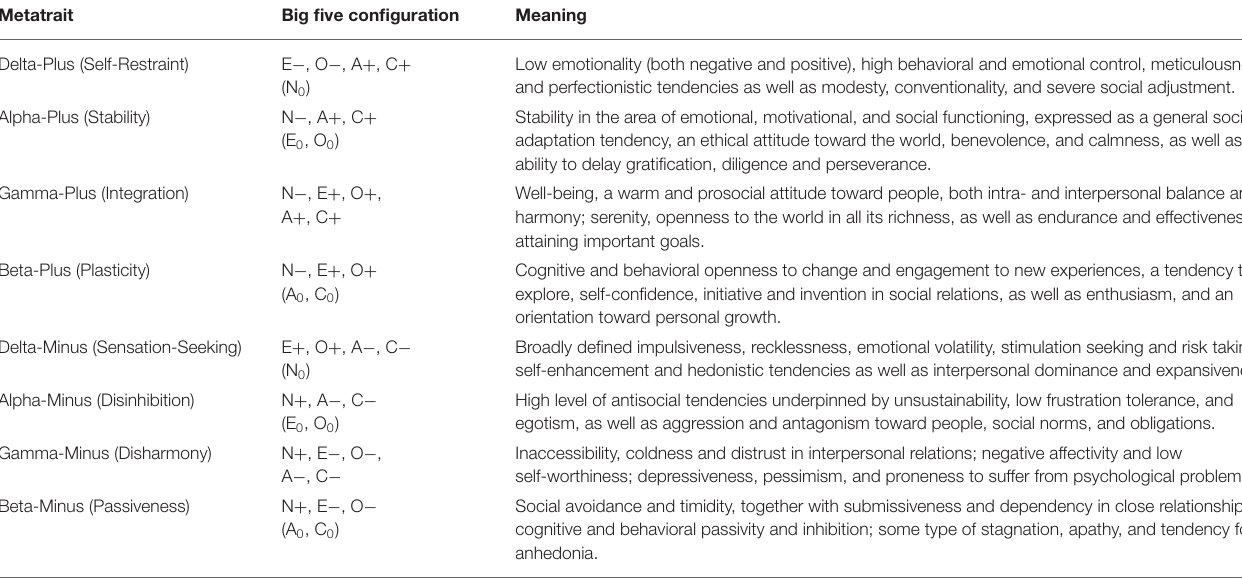
TABLE 1 | Description of the eight metatraits in the Circumplex of Personality Metatraits revised. Metatrait Big five configuration